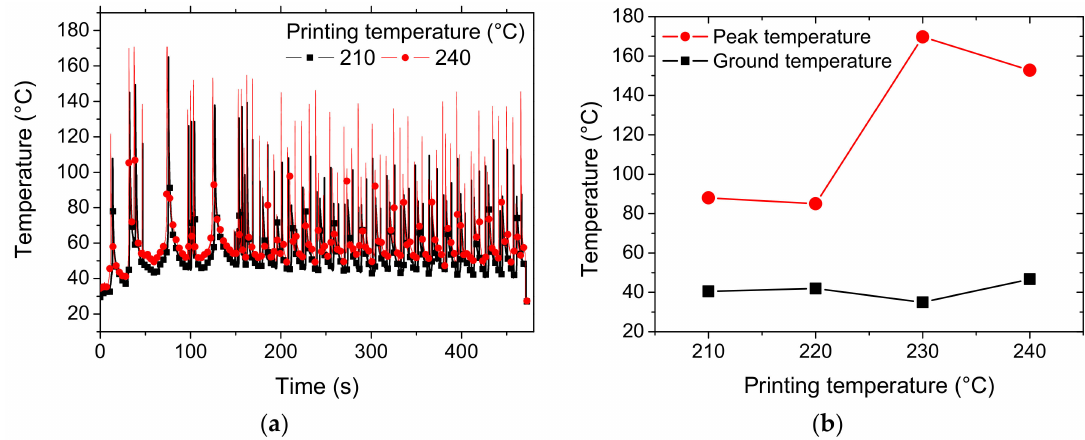
Figure 4. Results of infra-red measurement of the laying down process of wood-PLA / PHA filament: ( a ) thermal cycles for the minimum and maximum printing temperatures, ( b ) extracted ground and peak temperatures for all attempted printing